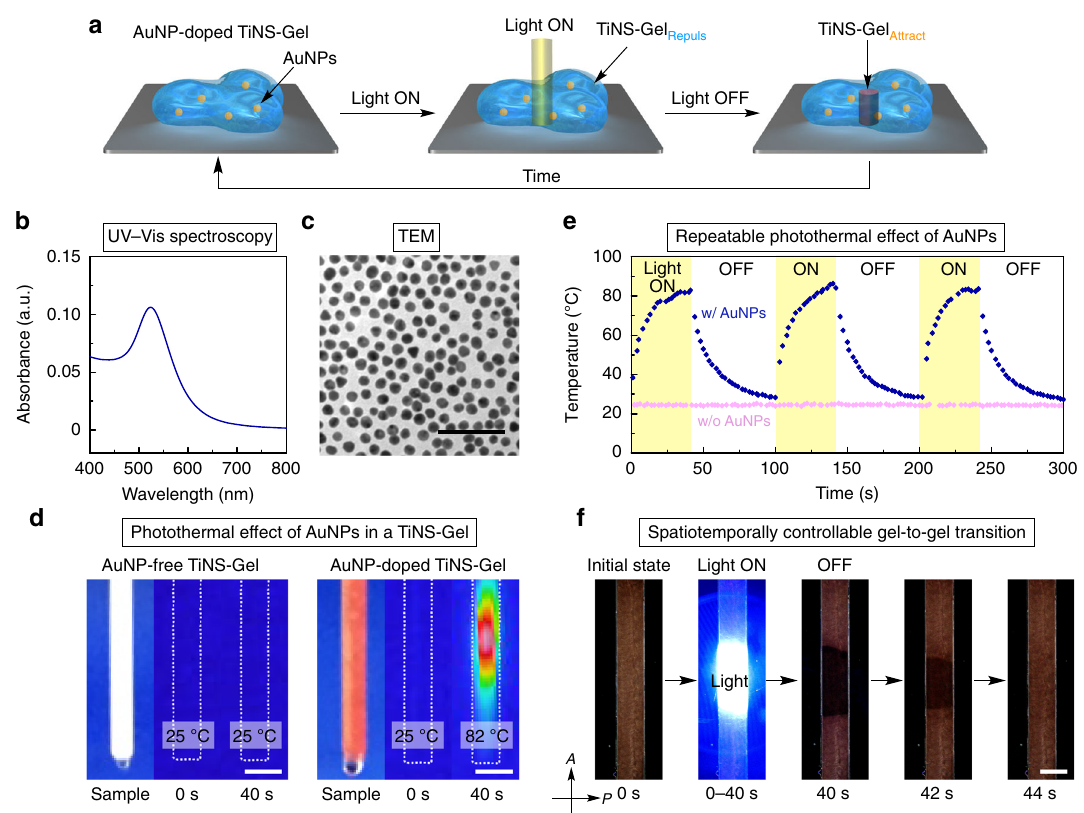
Fig. 5 Spatiotemporally controlled transition between TiNS-Gel Repuls and TiNS-Gel Attract in response to photo stimuli. a A schematic illustration for photoinduced gel-to-gel transition between TiNS-Gel Repul s and TiNS-Gel Attract . b , c Characterization of gold nanoparticles (AuNPs; average diameter = 17 nm); UV-Vis absorption spectrum of an aqueous dispersion ([AuNP] = 0.005 wt%; b ) and transmission electron microscopy image (TEM image; c ). d Photoinduced temperature changes upon irradiation with 445-nm laser light (power density = 5.6 W cm – 2 ) of TiNS-Gel ([TiNS] = 14 wt%) without (left) and with (right) 0.05 wt% AuNPs. Pictures of the samples in a 1.5-mm diameter glass capillary (left) and their thermal-imaging camera images before (mid) and after (right) 40-s light irradiation. e Time-course temperature changes of TiNS-Gel ([TiNS] = 14 wt%) without (pink dots) and with (navy dots) 0.05 wt% AuNPs upon repeated turning on and off of the 445-nm laser light, which were monitored by a thermal-imaging camera. f Photoinduced changes in POM images under crossed Nicols of TiNS-Gel doped with AuNPs ([TiNS] = 14 wt%; [AuNP] = 0.05 wt%). When TiNS-Gel Repuls in a 0.2-mm-thick glass container was irradiated with the 445-nm laser light (irradiated region = 2 × 4 mm) for 40 s, the irradiated region was selectively transformed into TiNS-Gel Attract with no birefringence. Upon ceasing photoirradiation, the irradiated region returned to TiNS-Gel Repuls with a large birefringence within 4 s. This cycle could be repeated many times without deterioration (Supplementary Movie 1). Scale bars: 100 nm ( c ); 2 mm ( d , f